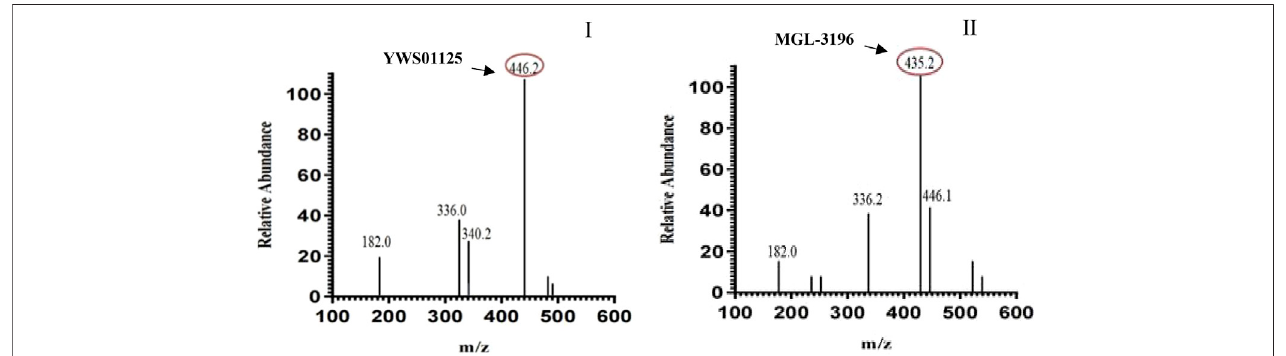
FIGURE 4 | Positive-ion electrospray mass spectra of YWS01125 (I) and IS